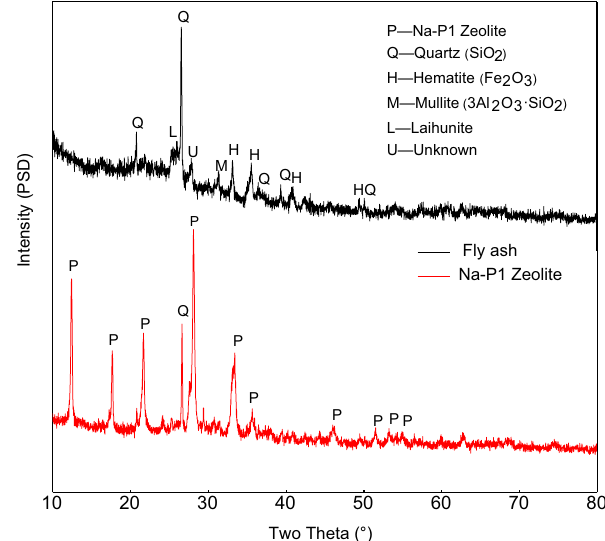
Figure 1: XRD patterns of fl y ash and synthetic